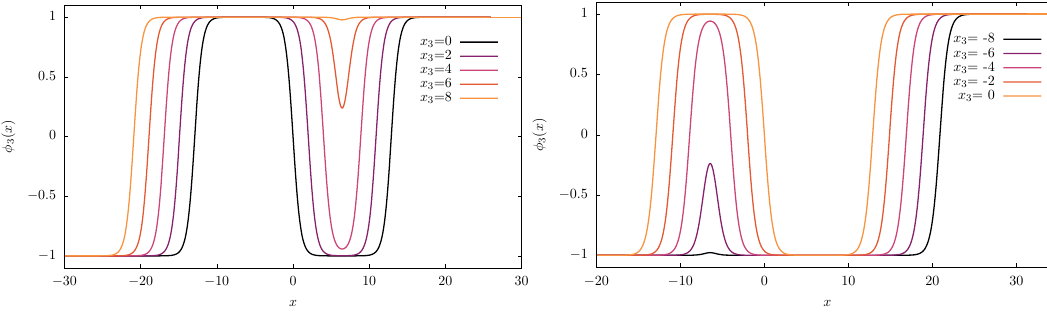
Figure 3 . Re(cid:13)ection-asymmetric solutions (cid:30) 3 for c = 10 5